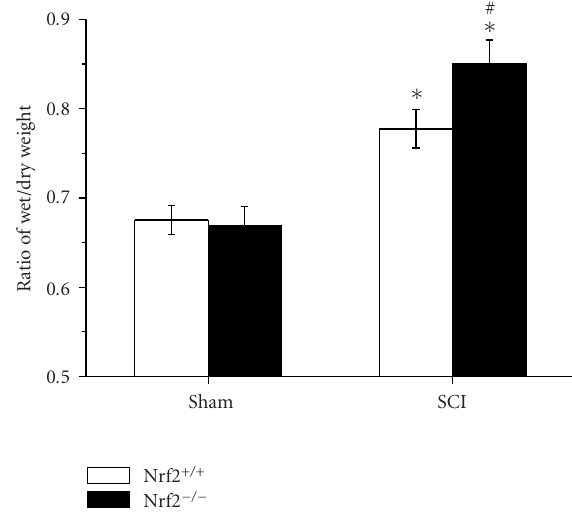
Figure 1: Spinal cord tissue water content in sham and injured Nrf2 (+/+) and Nrf2 ( − / − ) mice. The figure indicates that the spinal cord water content was significantly increased and was higher in Nrf2 ( − / − ) mice than that in Nrf2 ( − / − ) mice after SCI. Bars represent mean ± S.E. ( n = 6, each group). ∗ P < . 01 versus genotype- matched sham-operated mice. # P < . 05 versus treatment-matched Nrf2 (+/+)